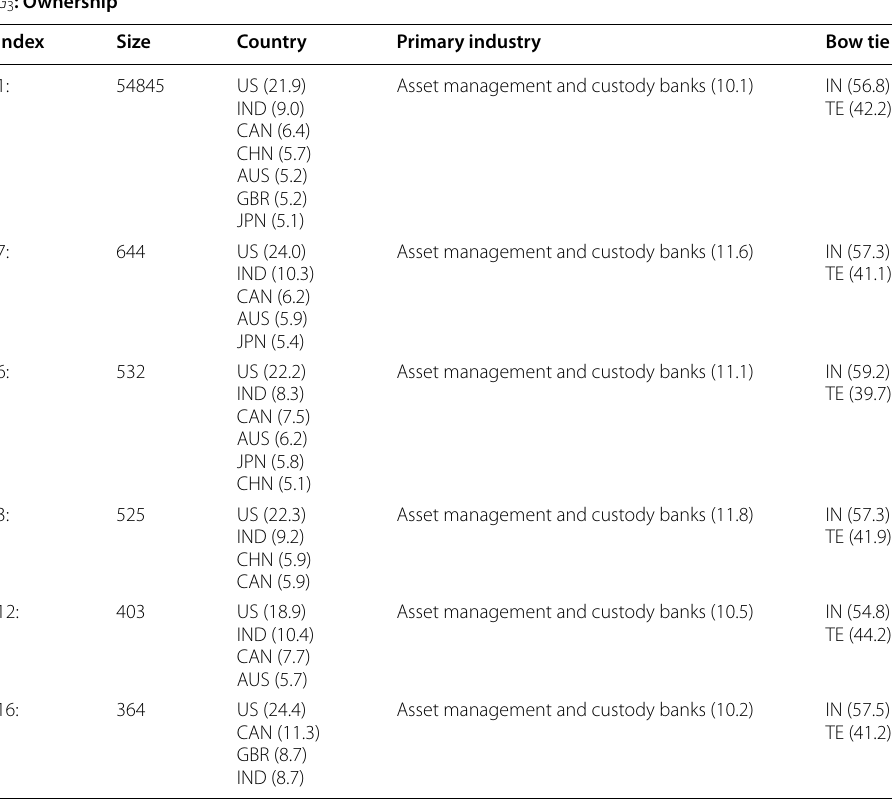
Table 11 Characteristics of the six largest communities at the first level for the ownership layer